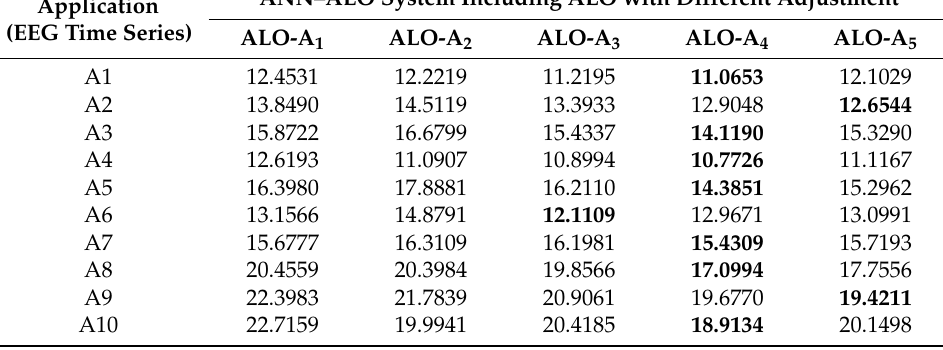
Table 5. Mean absolute error (MAE) values calculated for each EEG time series (Figure 5) via different ANN–ALO adjustments.